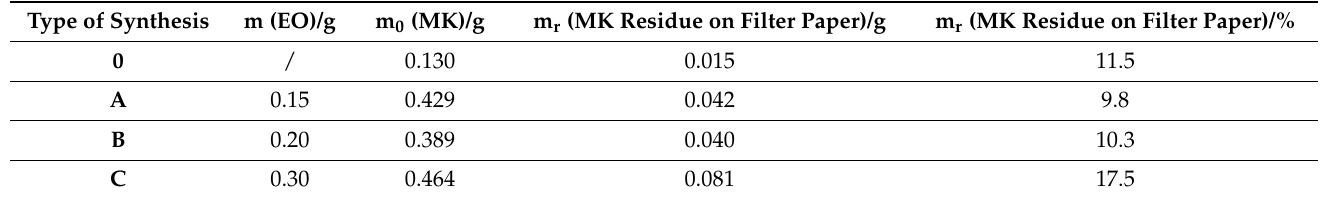
Table 1. Synthesis of microcapsules with the corresponding results of gravimetric analysis. Type of Synthesis